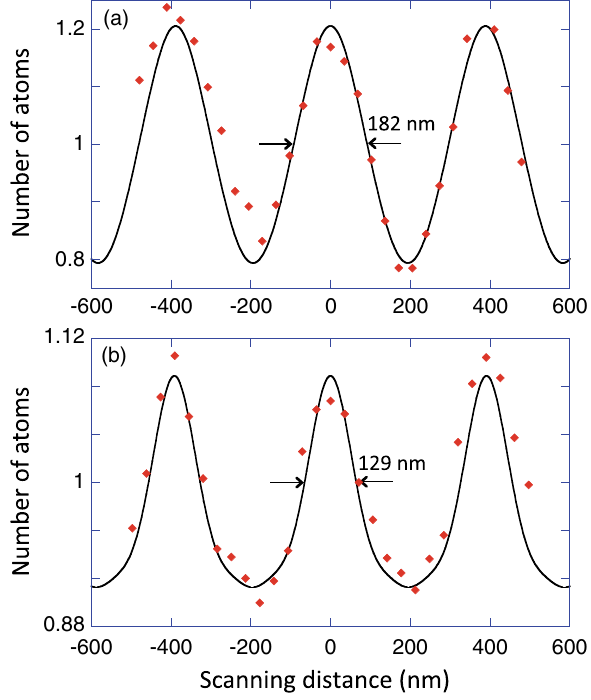
FIG. 6. The normalized number of atoms that remain in the trap as a function of the scanning distance of the standing wave. For these data, the power of the probe beam is held at a constant value of 5 mW. The coupling laser power changes from 3 mW to 14 mW for part (a), and 3 mW to 30 mW for part (b). The solid lines are the results of numerical simulations, where we solve the density matrix equations at each point along the spatial profile of the standing wave. The simulations also take into account the diffusion of the atoms due to their finite temperature.